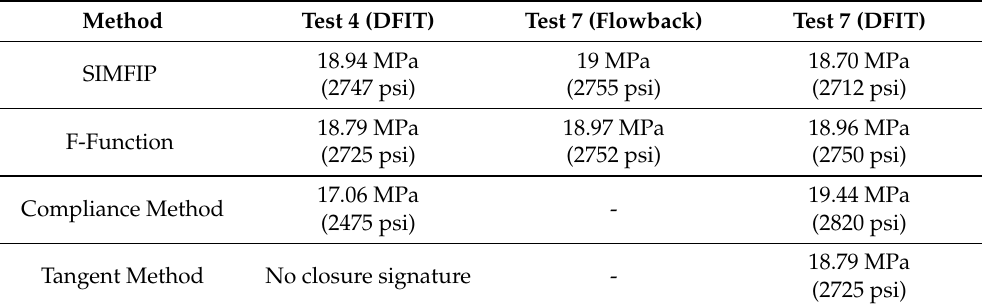
Table 7. Summary of tests 4 and 7 analysis.